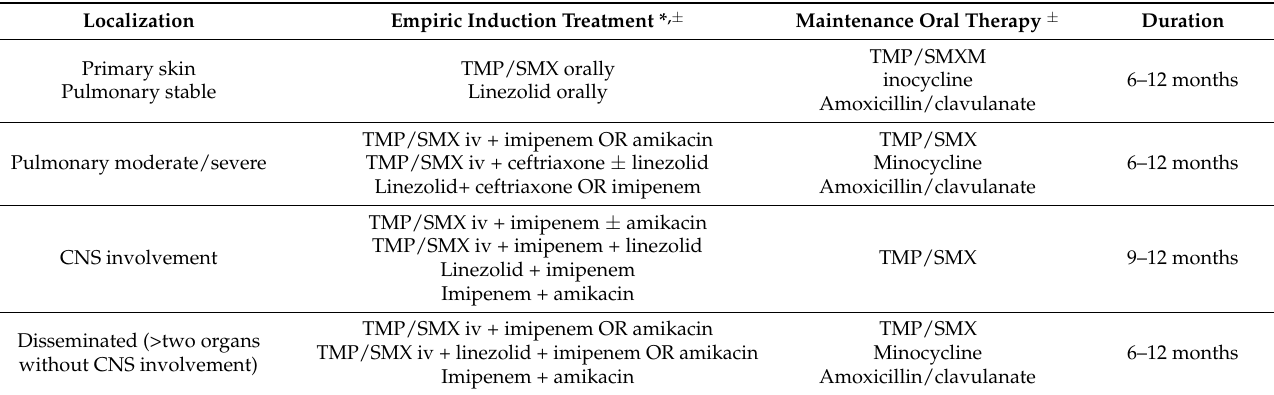
Table 3. Therapeutic management of nocardiosis according to clinical